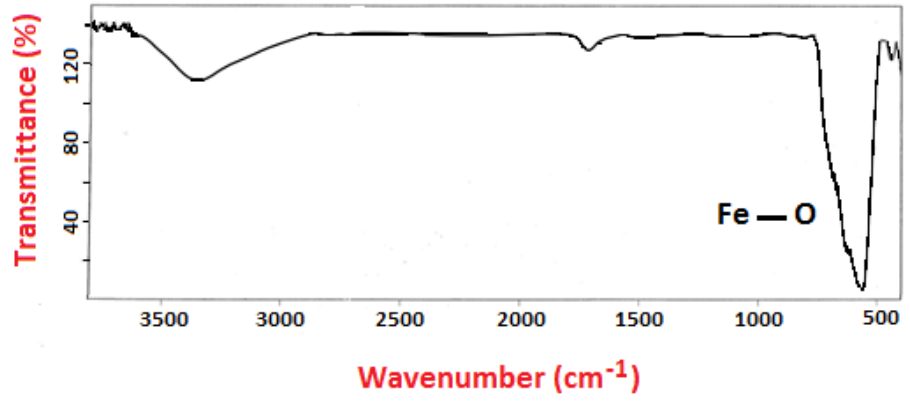
Figure 1. FT-IR spectrum of Fe 3 O 4 MNPs.